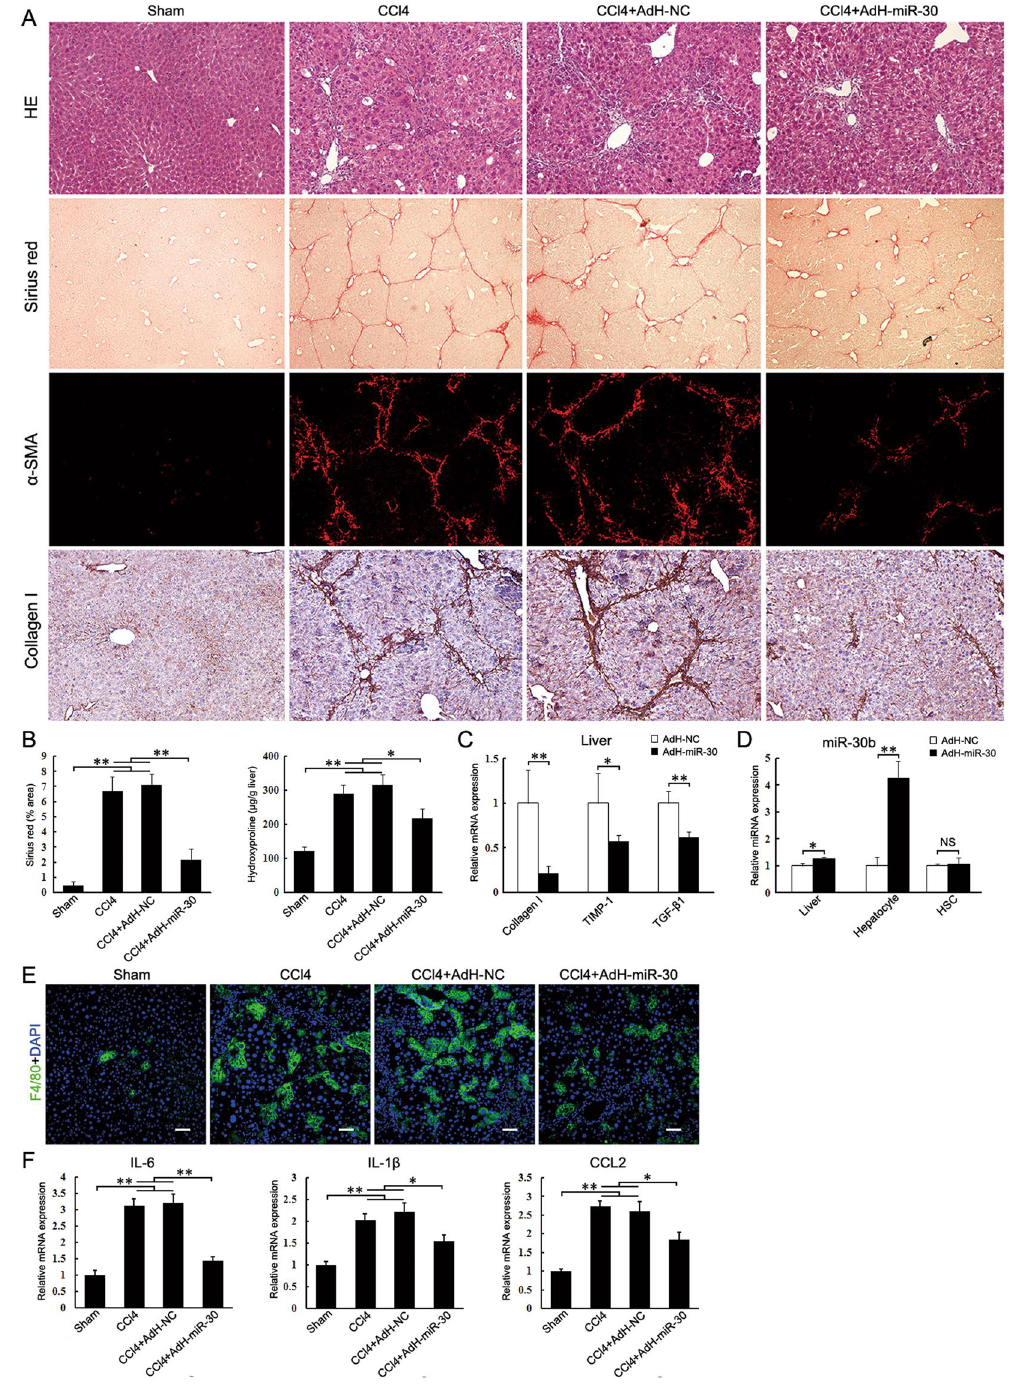
Figure 3. Ectopic expression of miR-30b in hepatocyte suppresses CCl 4 -induced liver fibrosis. Mice were treated with oil (Sham, n = 6), CCl 4 (CCl4, n = 6), CCl 4 in combination with injection of AdH-NC (CCl4 + AdH-NC, n = 6) and CCl 4 in combination with injection of AdH-miR-30 (CCl4 + AdH-miR-30, n = 6). The mice were sacrificed after 3 weeks CCl 4 treatment. ( A ) Liver fibrosis was evaluated by H&E staining (100 × ), sirius red staining (40 × ), α -SMA immunofluorescence staining (100 × ) and collagen I immunohistochemical staining (100 × ). ( B ) Quantifications of the sirius red positive area and hepatic hydroxyproline content. The hydroxyproline contents are expressed as μ g/g wet liver weight. ( C ) Hepatic Collagen I, TIMP-1 and TGF- β 1 mRNA were determined by qRT-PCR. ( D ) miR-30b level in the whole liver, isolated hepatocytes and HSCs were determined by qRT-PCR respectively. ( E ) Immunofluorescence staining of liver sections with anti-F4/80 antibody. Scale bar, 50 μ m. ( F ) Hepatic IL-6, IL-1 β and CCL2 mRNA were determined by qRT-PCR. The results are shown as fold change compared with Sham group or AdH-NC group mice. Data are the mean ± SEM of three independent experiments. * P < 0.05, ** P < 0.01. NS, no significant